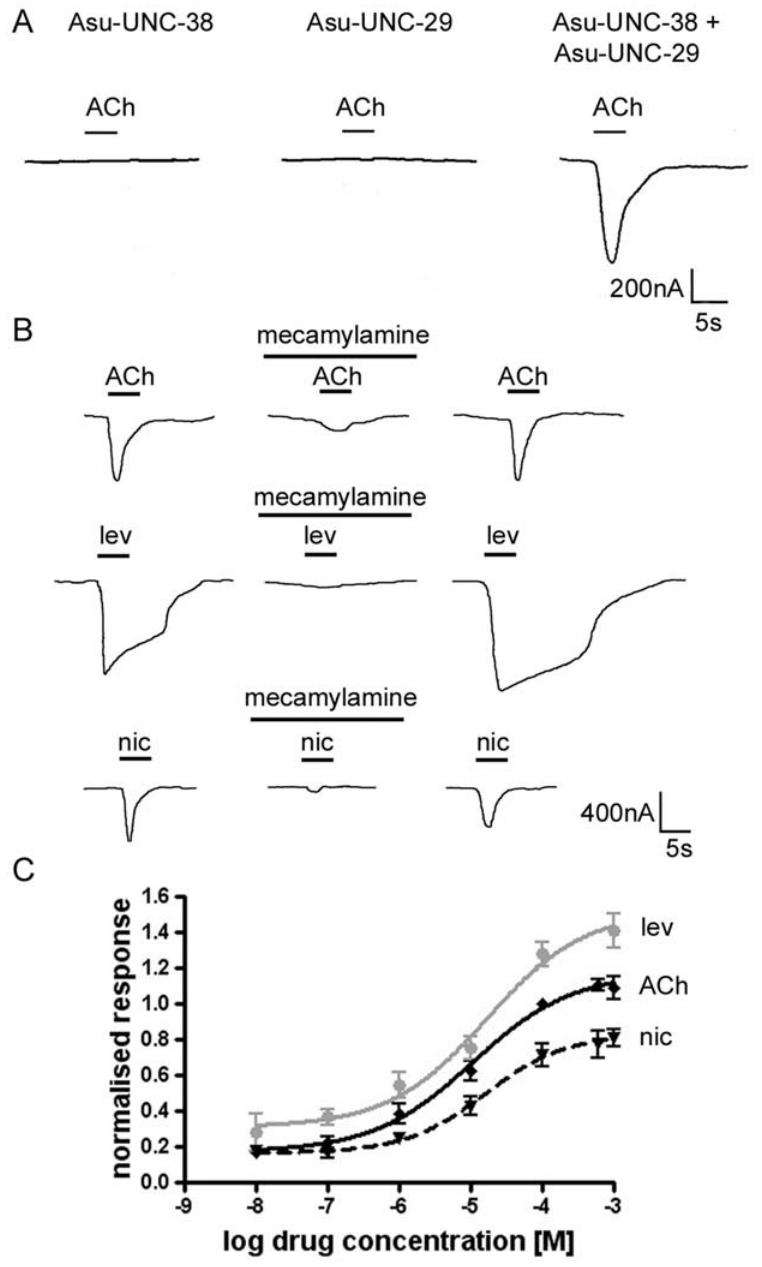
Figure 3. Two-electrode voltage clamp electrophysiological experiments on Xenopus oocytes. A) Oocytes injected with Asu- unc-38 or Asu-unc-29 cRNAs alone produced no functional receptors, whereas oocytes injected with both subunit cRNAs in an equimolar ratio gave robust responses to application of 100 m M acetylcholine (ACh). B) Oocytes injected with an equimolar ratio of Asu-unc-38 and Asu-unc-29 cRNA responded to 100 m M acetylcholine (ACh), 100 m M levamisole (lev) and 100 m M nicotine (nic). These responses could all be reversibly blocked by application of 10 m M mecamylamine. C) Dose-response relationships for the agonists levamisole (lev, grey circles), acetylcholine (ACh, black diamonds) and nicotine (nic, black triangles) from oocytes injected with an equimolar ratio of Asu-unc-38 and Asu-unc-29 . Responses are all normalized to the response to 100 m M acetylcholine. N=3 (where N is batches of oocytes) and n=6 (where n is the number of individual oocytes) minimum for each data point.